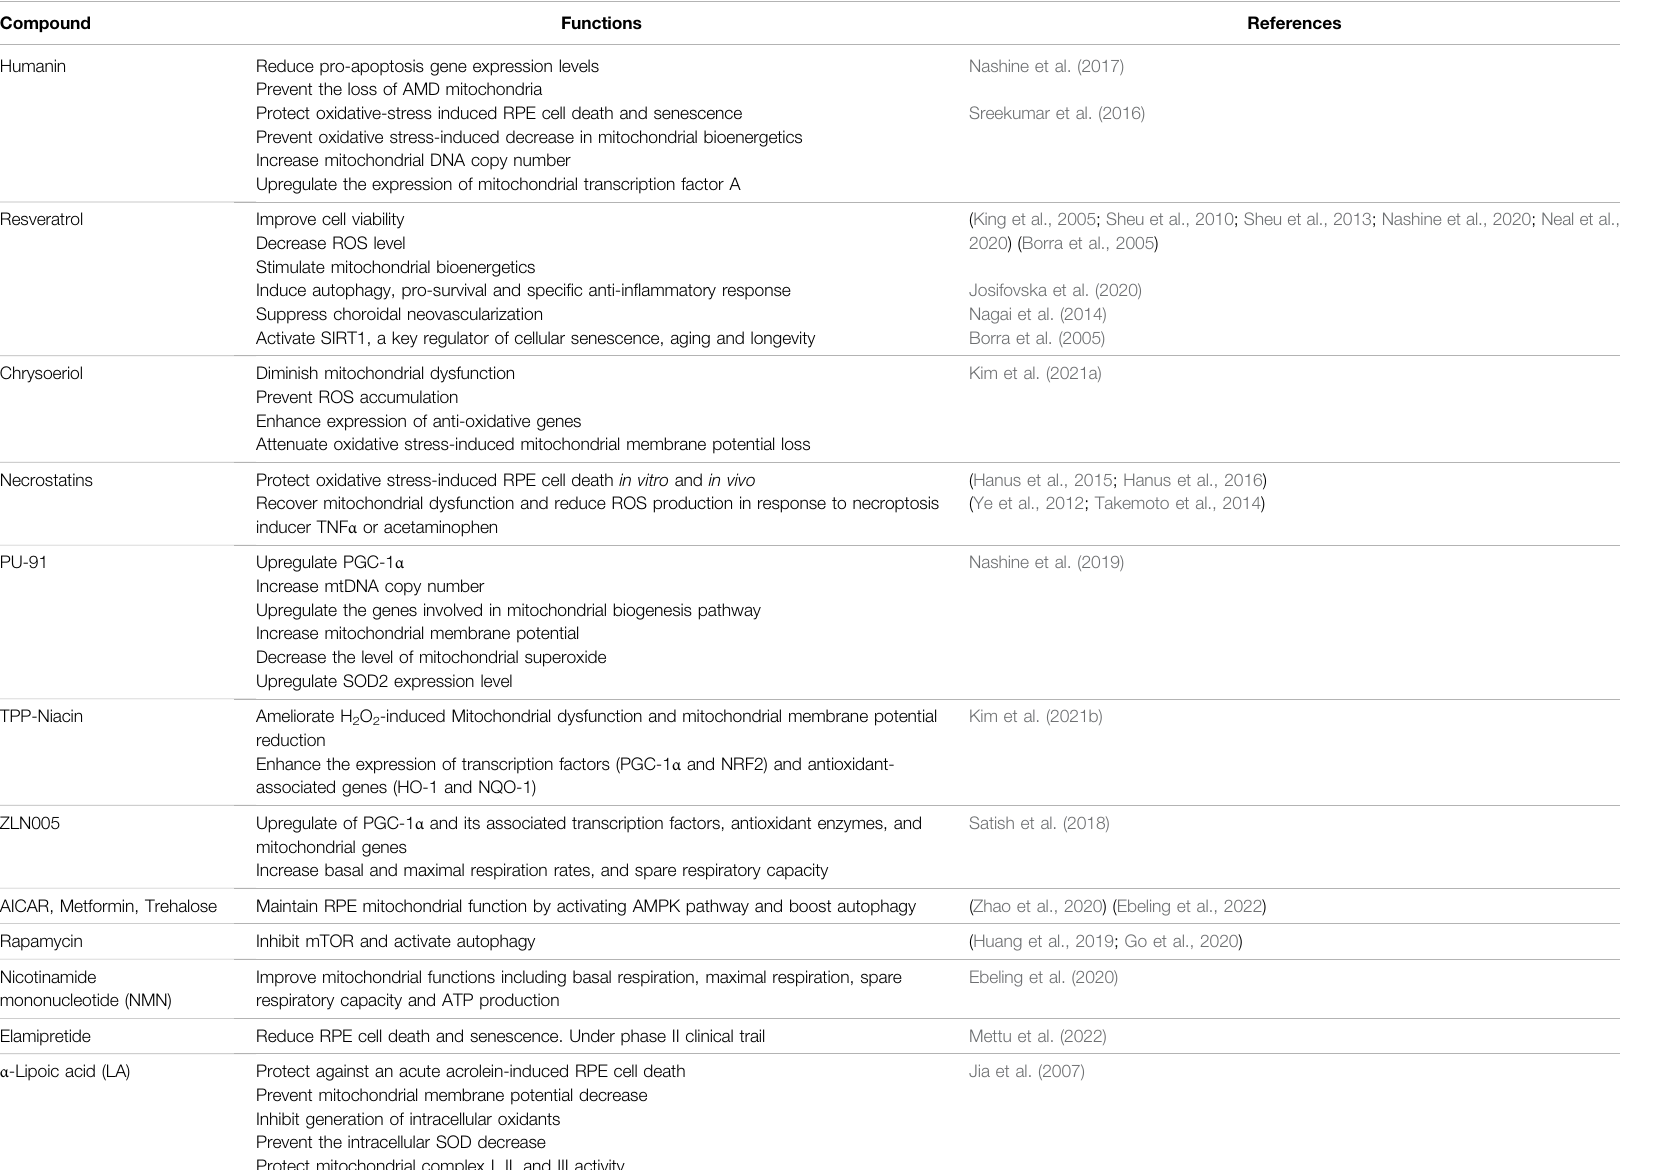
TABLE 3 | Potential therapeutics for RPE Aging and AMD through restoring mitochondrial